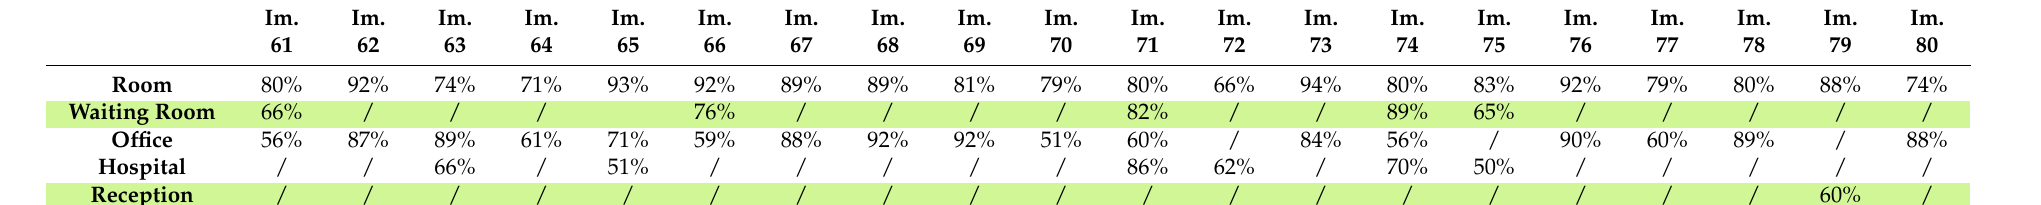
Table A4. Percentage of confidence obtained with Google Vision API for the “acceptance” IU. Each column corresponds to Image 61 to 80 and each row is related to a different label that was returned by the